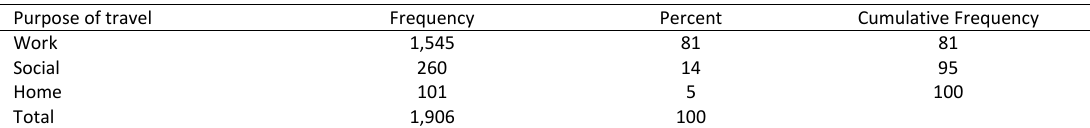
Table 1: Distribution of the primary purpose of travel